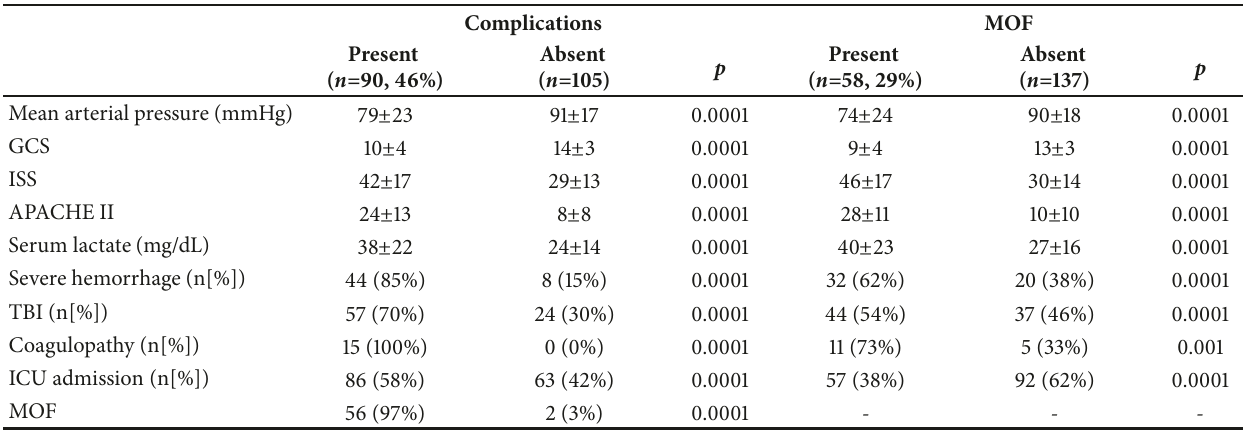
Table 6: Descriptive statics for Glasgow ComaScore,Injury Severity Score,AcutePhysiology andChronic Health EvaluationII, serumlactate level, traumatic brain injury, coagulopthy, hemorrhage, and intensive care unit admission among patients who developed complications and multiorgan failure.